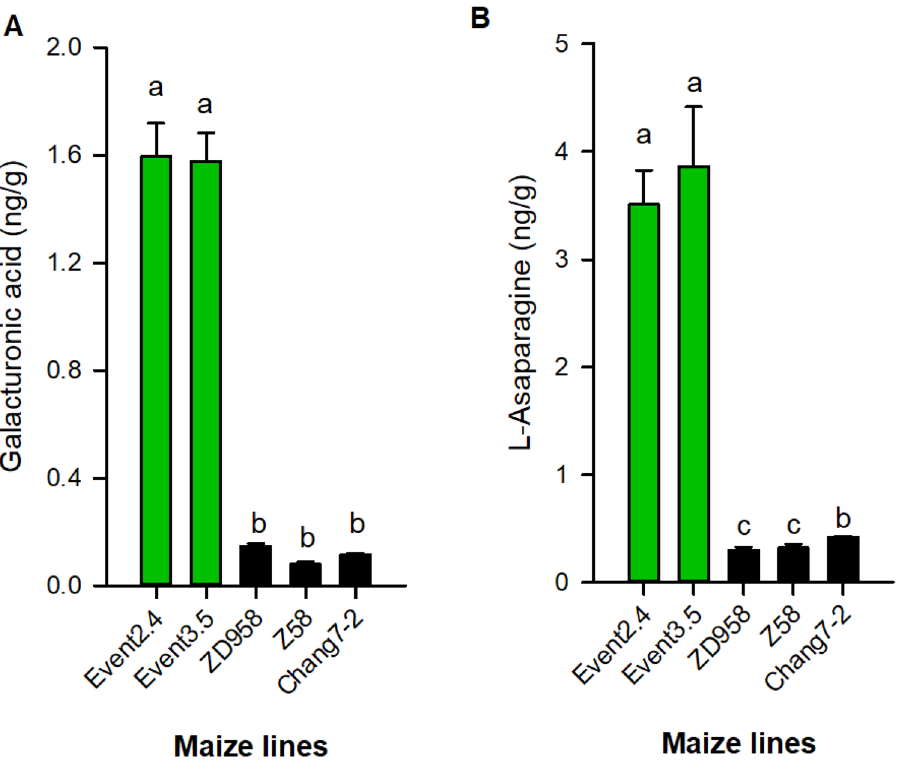
Figure 5. Targeted metabolites measurement to confirm the contents changes induced by HIR gene cassette effects using LC–MS/MS with standard curve (a-b). Different alphabet letters represent significant differences at P < 0.05 based on one-way ANOVA . n =